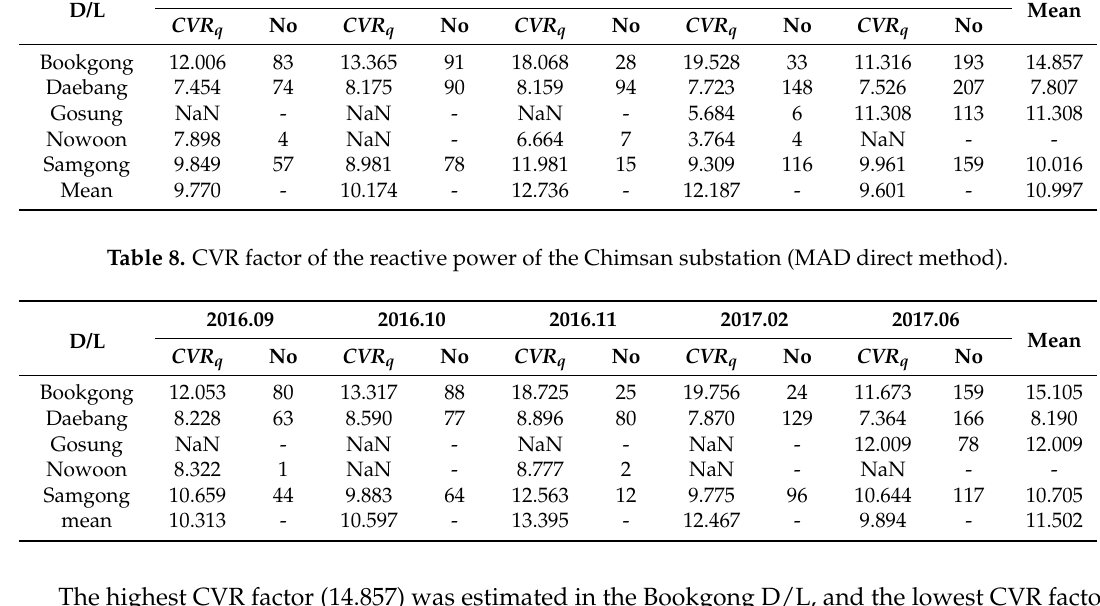
Table 7. CVR factor of the reactive power of the Chimsan substation (direct method).